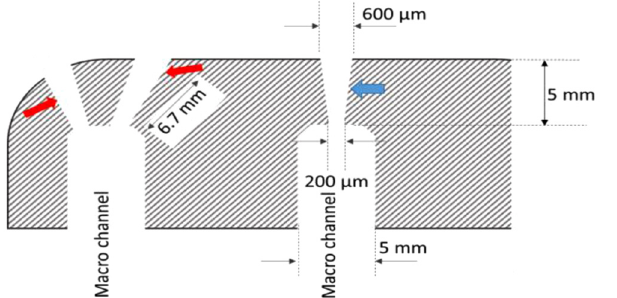
Fig. 8. Geometry and position of the microholes: depth of 5 mm for perpendicular (assigned with blue arrow) and depth of 6.7 mm for angled microholes (assigned with red arrows). The microholes are connected to the macro channel, which were manufactured by conventional mechanical